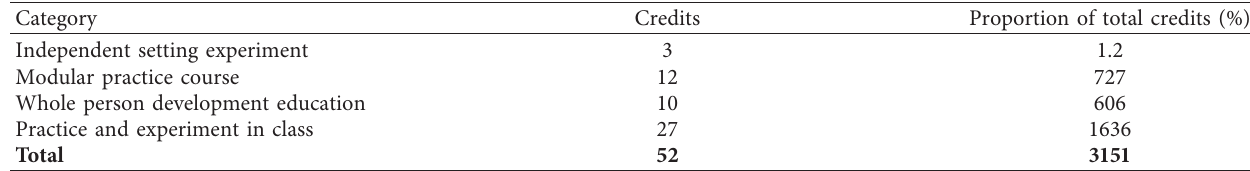
Table 5: Practice credit